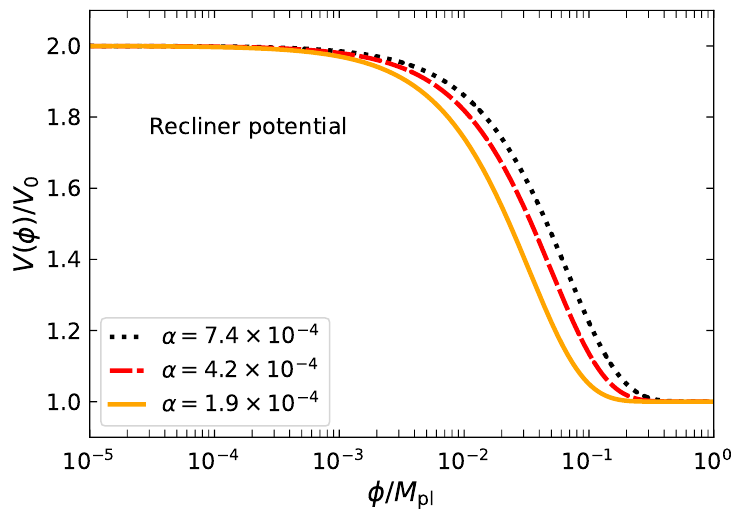
Figure 1. Recliner potential for different values of the parameter α as a function of the scalar field φ . The blue dotted line shows the potential with α = 7.4 × 10 − 4 , the red dashed line a model with α = 4.2 × 10 − 4 and finally the orange solid curve shows a potential with α = 1.9 × 10 − 4 .